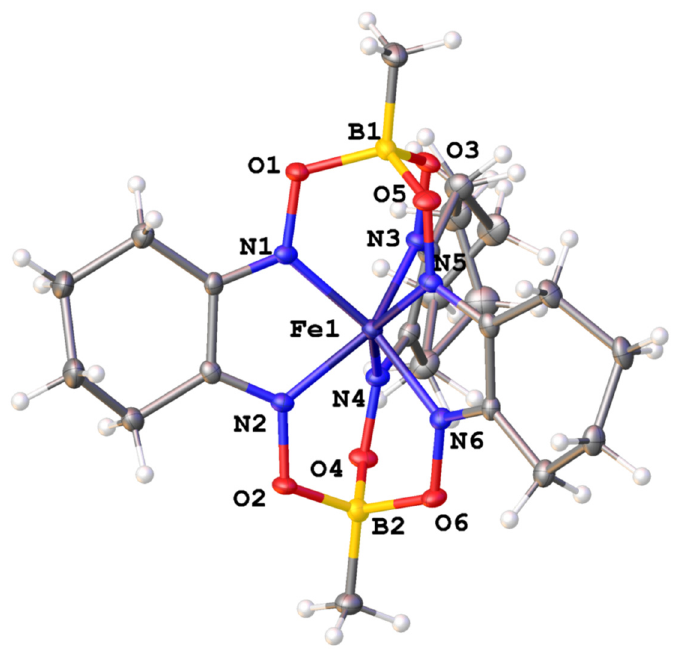
Figure 9. General view of the molecule FeNx 3 (BCH 3 ) 2 ( 4 ) in representation of its atoms with thermal ellipsoids ( p = 50%).